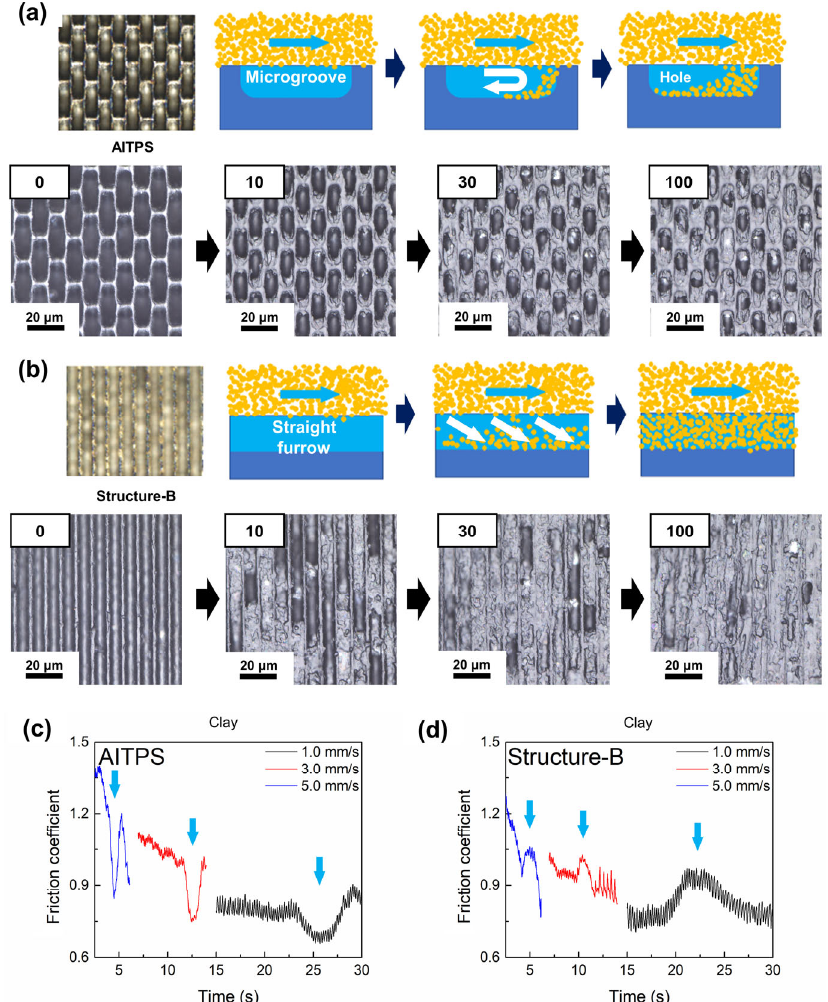
Fig. 8 Resistance reduction mechanisms: (a, b) schematic illustrations and microscopic images of AITPS and Structure-B after 0th, 10th, 30th, and 100th times of measurements, respectively; (c, d) friction coefficient curves of AITPS and Structure-B after 100th tests at different measuring speeds (1.0, 3.0, and 5.0 mm/s),